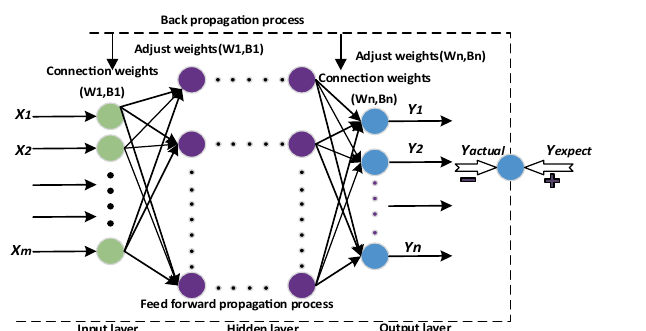
Figure 6. Schematic diagram of